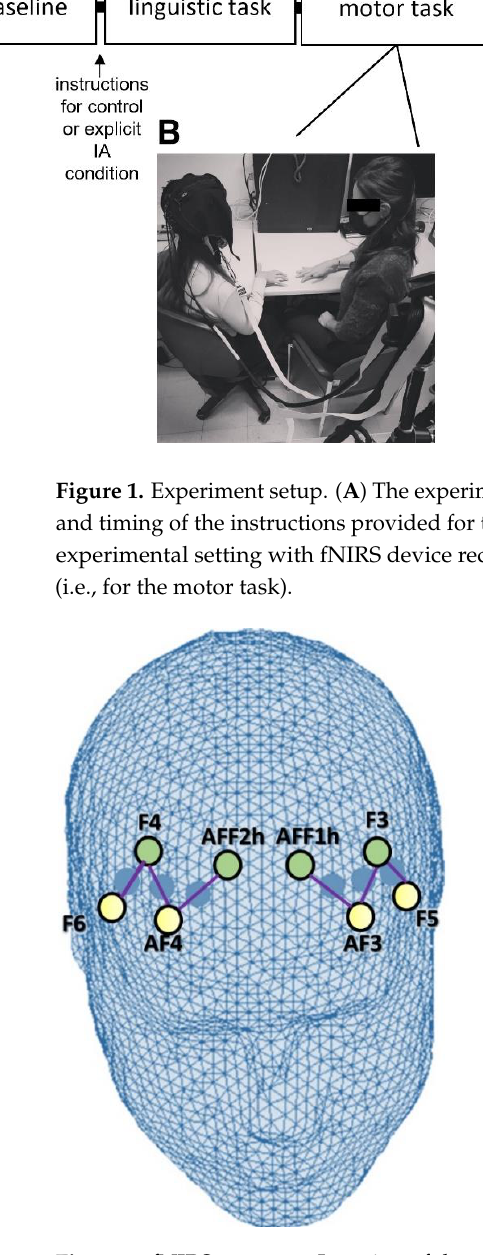
Figure 2. fNIRS montage. Location of the sources (yellow) and detectors (green) of fNIRS montage. Sources were in the following positions: AF3-AF4, F5-F6. Detectors were placed on: AFF1h-AFF2h,